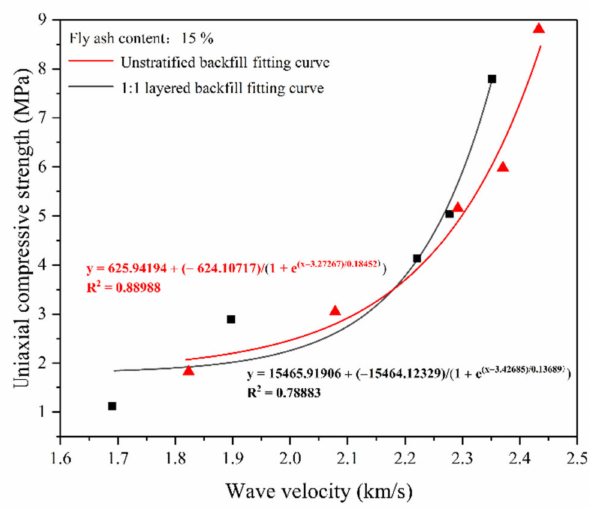
Figure 15. Fitting relationship between the wave velocity and uniaxial compression strength of